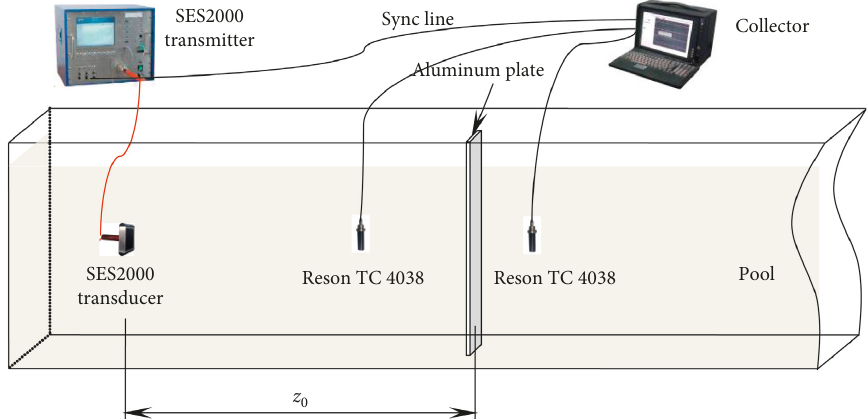
Figure 6: Experimental setup for the measurement of sound propagation through inclined plane.